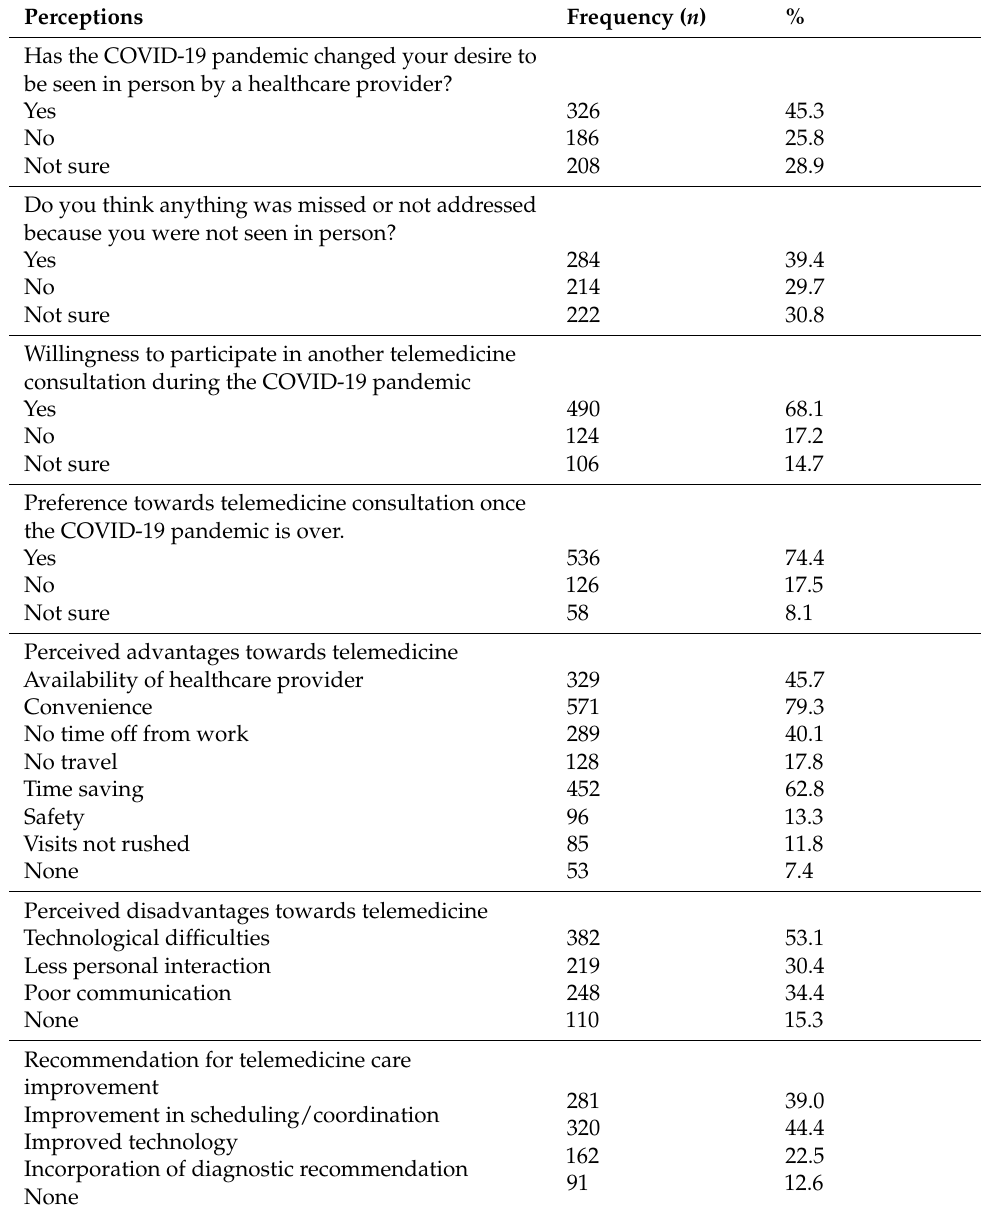
Table 3. Patients’ perceptions towards virtual outpatient clinic consultation ( n = 720).